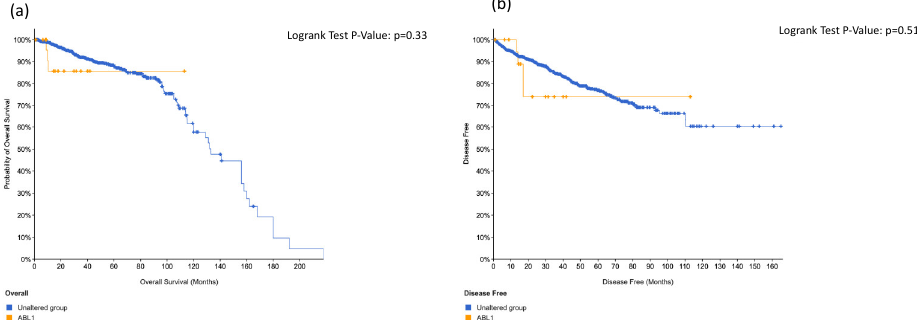
Figure 3. Overall survival ( a ) and disease-free survival ( b ) in ERRB4-positive prostate cancer patients.